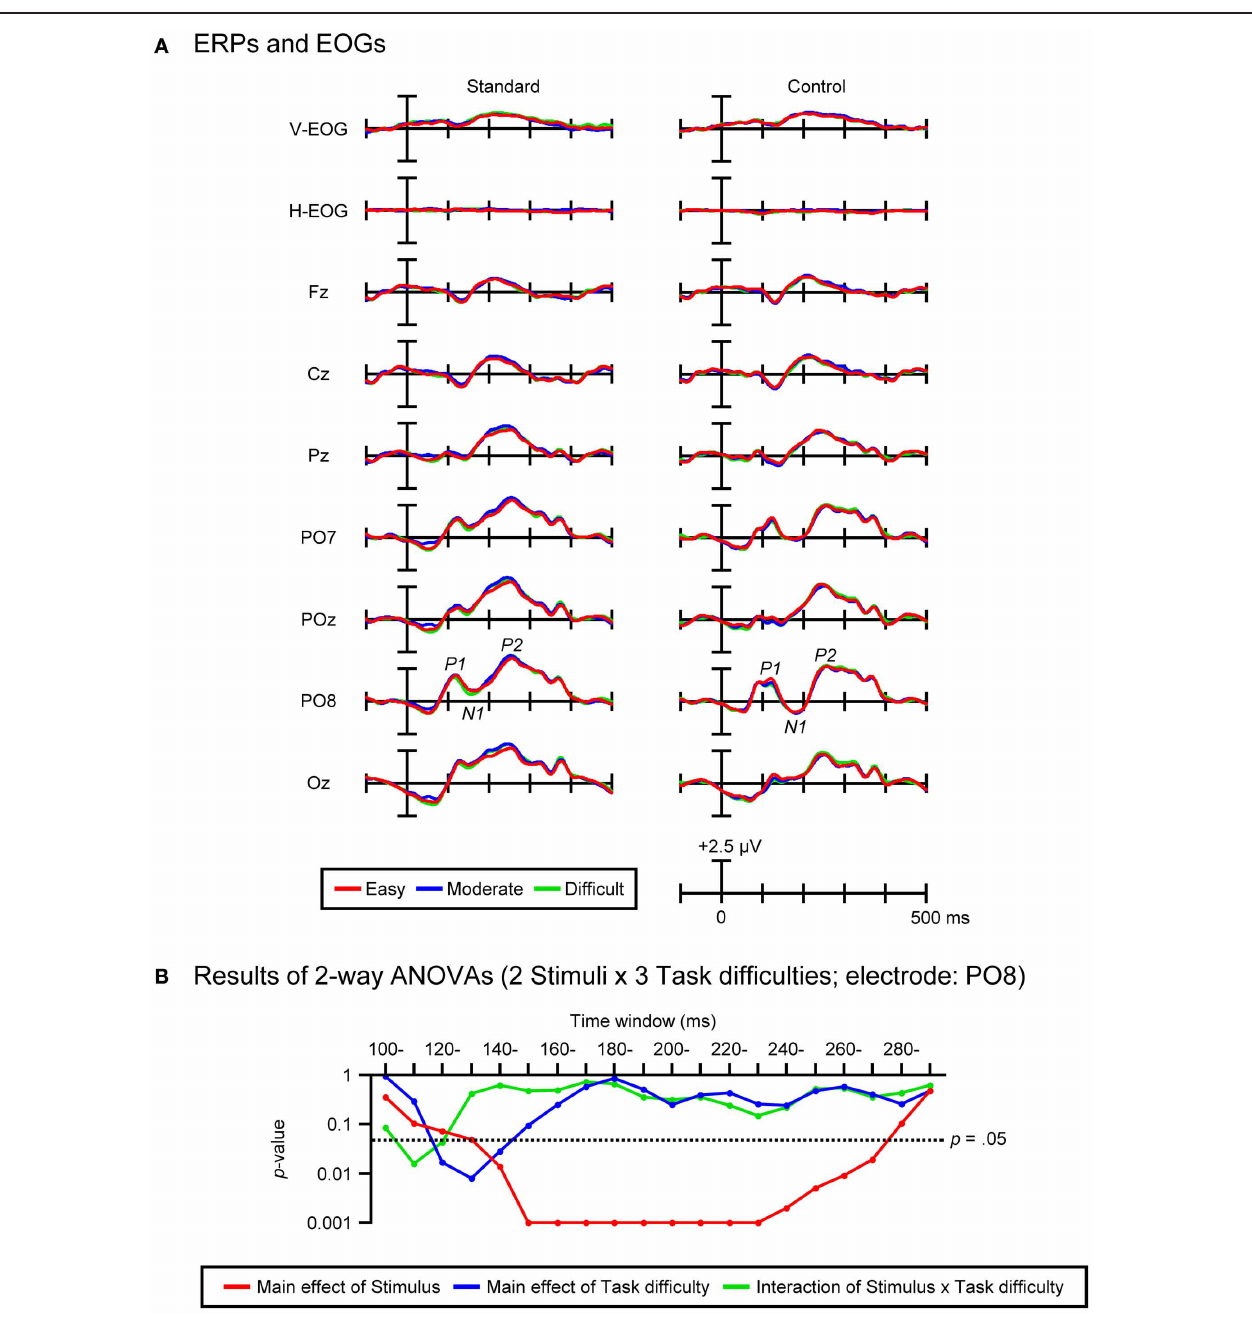
FIGURE 5 | (A) Grand-average ERPs and EOGs in response to standard (left column) and control stimuli (right column) in the easy, moderate, and difficult conditions. (B) Results of Two-Way ANOVAs (2 Stimuli × 3 Task